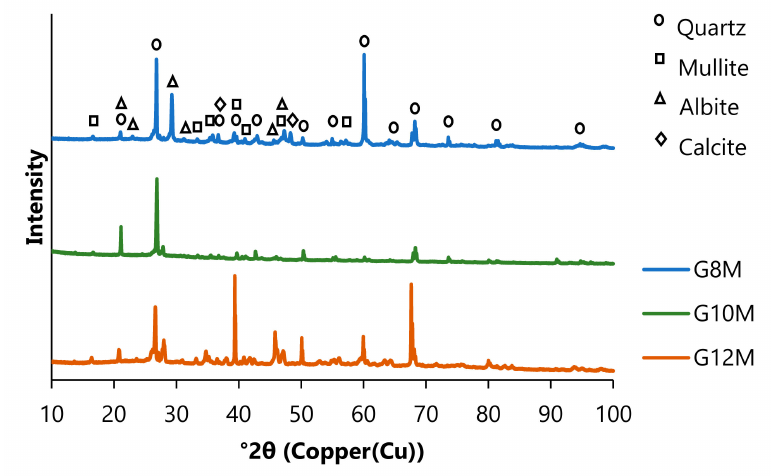
Figure 17. XRD of geopolymers after three years of ageing, resoaking in distilled water, and drying. Table 6. Qualitative and quantitative analysis of identified phases in geopolymers after three years of ageing, resoaking in distilled water, and drying.